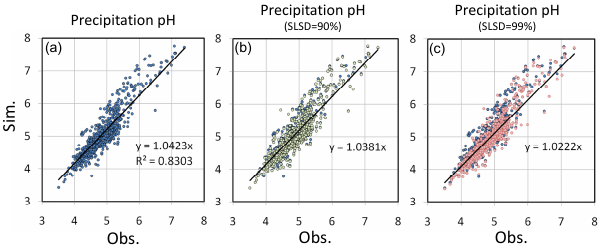
Obs. Obs. Obs. Fig. 8. Scatter diagrams of daily precipitation pH at NC stations, (x-axis) observed and (y-axis) calculated using (a) observed chem- ical compositions (blue), (b) with 90% of the components derived from sea salt excluded (green), and (c) with 99% of the components derived from sea salt excluded